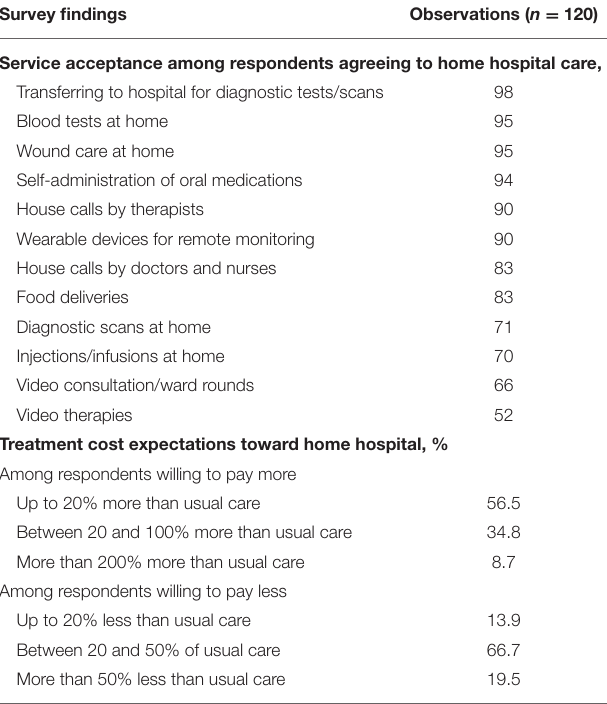
TABLE 3 | Logistic regression model determining the association between HaH programme acceptance and selected determinants. Odds ratio p